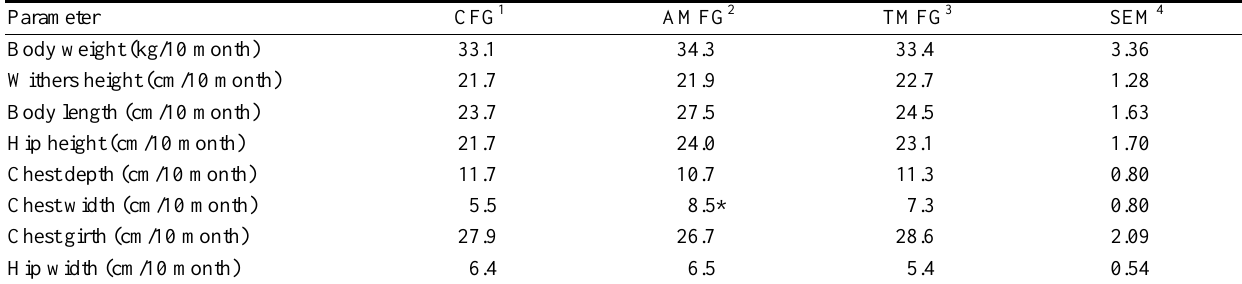
Table 8. Effect of feeding Awamori-pressed lees mixed feed (AMF) and Tofu lees mixed feed (TMF) on cumulative growth of female goats